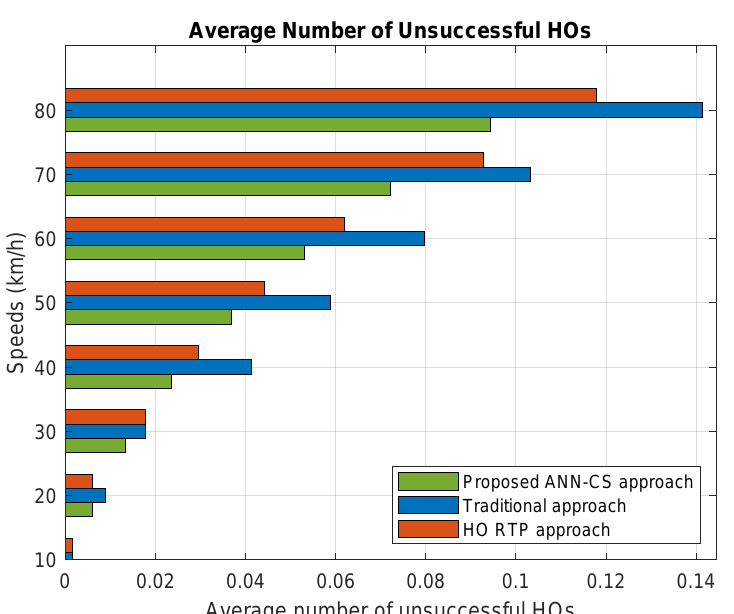
Figure 11. Average number of unsuccessful